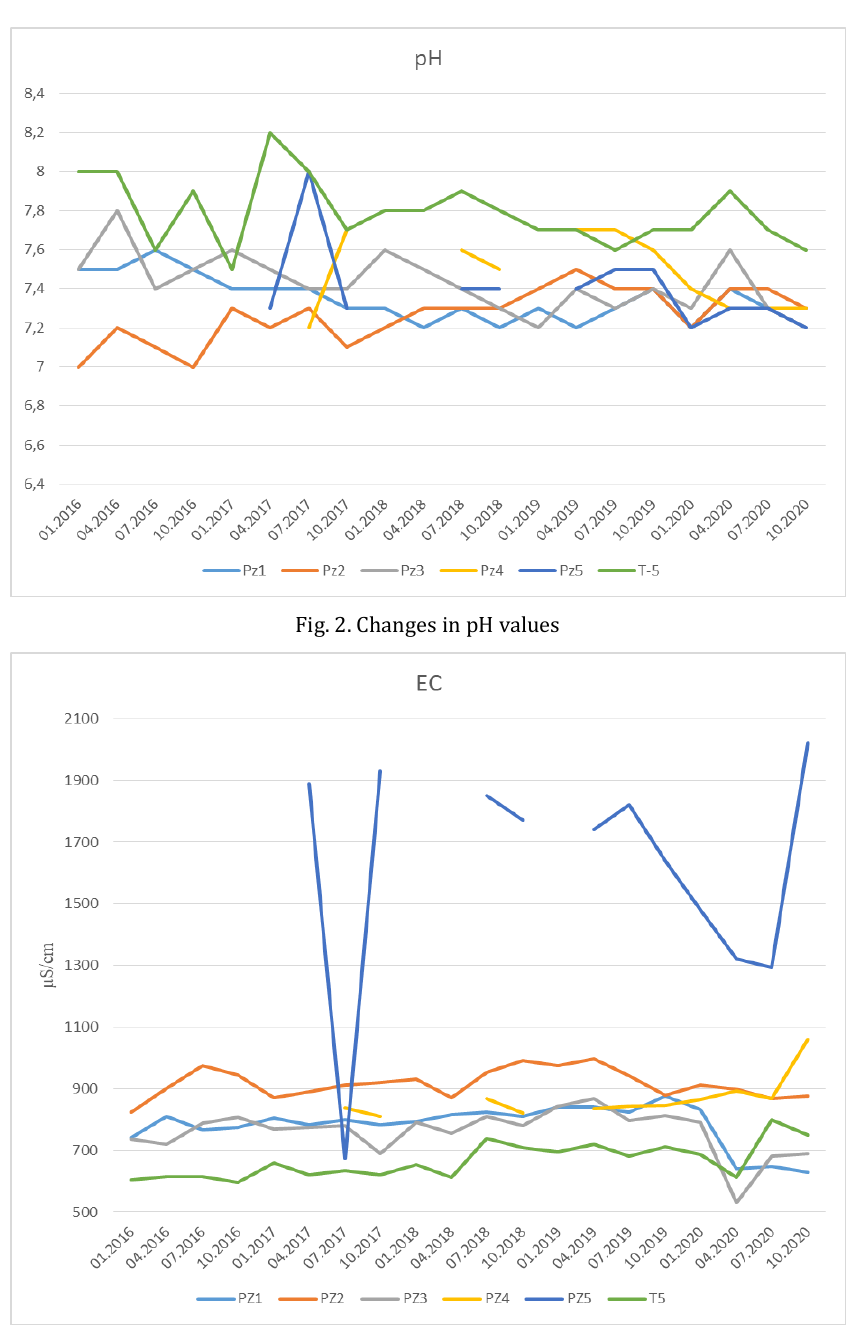
Fig. 3. Changes in EC